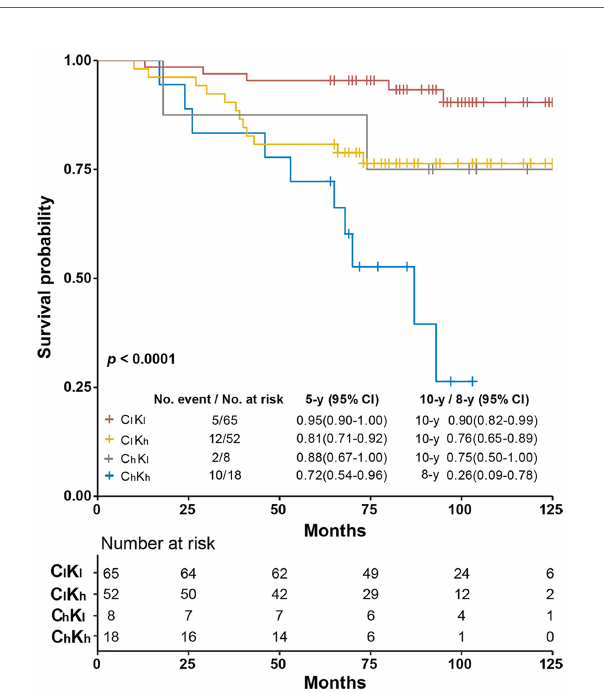
FIGURE 3 | Kaplan – Meier survivalanalysis ofoverallsurvivalofLuminal-like specimens subgroupedbyobjectivelyquantitatedKi67andcyclinD1proteinlevels. Thespecimenswereseparatedintofour subgroups usingcyclinD1at0.44 m mol/g andKi67at2.31nmol/gascutoffs, respectively.C l K l standsforspecimens withthe proteinlevelsofbothbiomarkersbelowtherespectivecutoffs, C l K h for thosewith onlycyclinD1levelbelow the recommendedcutoff, C h K l forthosewithonlyKi67 levels below therecommendedcutoff,andC h K h forthosewithbothbiomarkers abovetherespectivecutoffs. The5- and10-yearsurvivalprobabilitiesandthe p - valuesfrom log-ranktestwereprovidedinthe fi